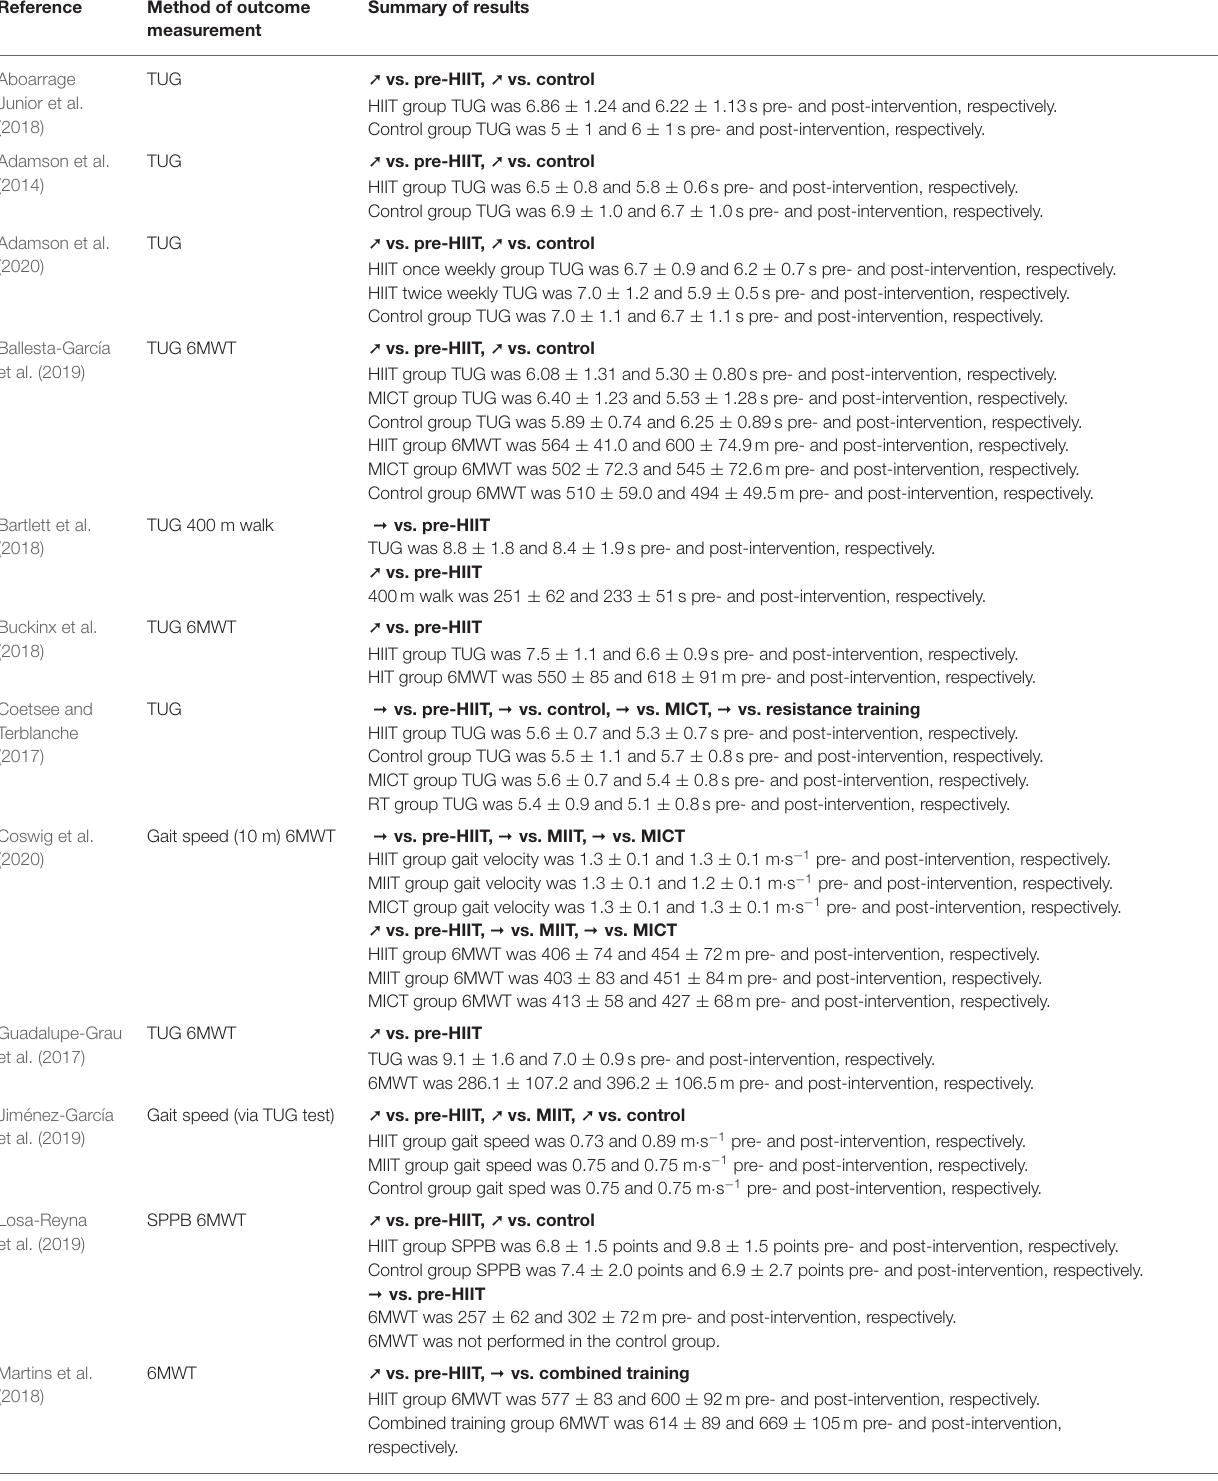
TABLE 4 | Summary of study details concerning HIIT and physical performance. Reference Method of outcome